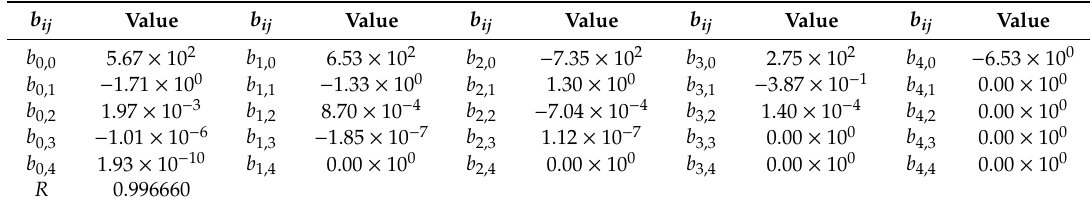
Table 4. Material constants b ij of the polynomial n ( ε , T ) (8).